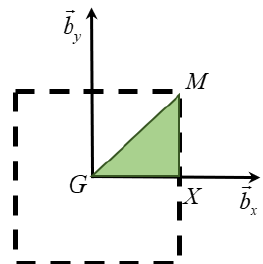
Figure 6. First Brillouin zone (FBZ, dashed square) and irreducible Brillouin zone (IBZ, colored triangle).